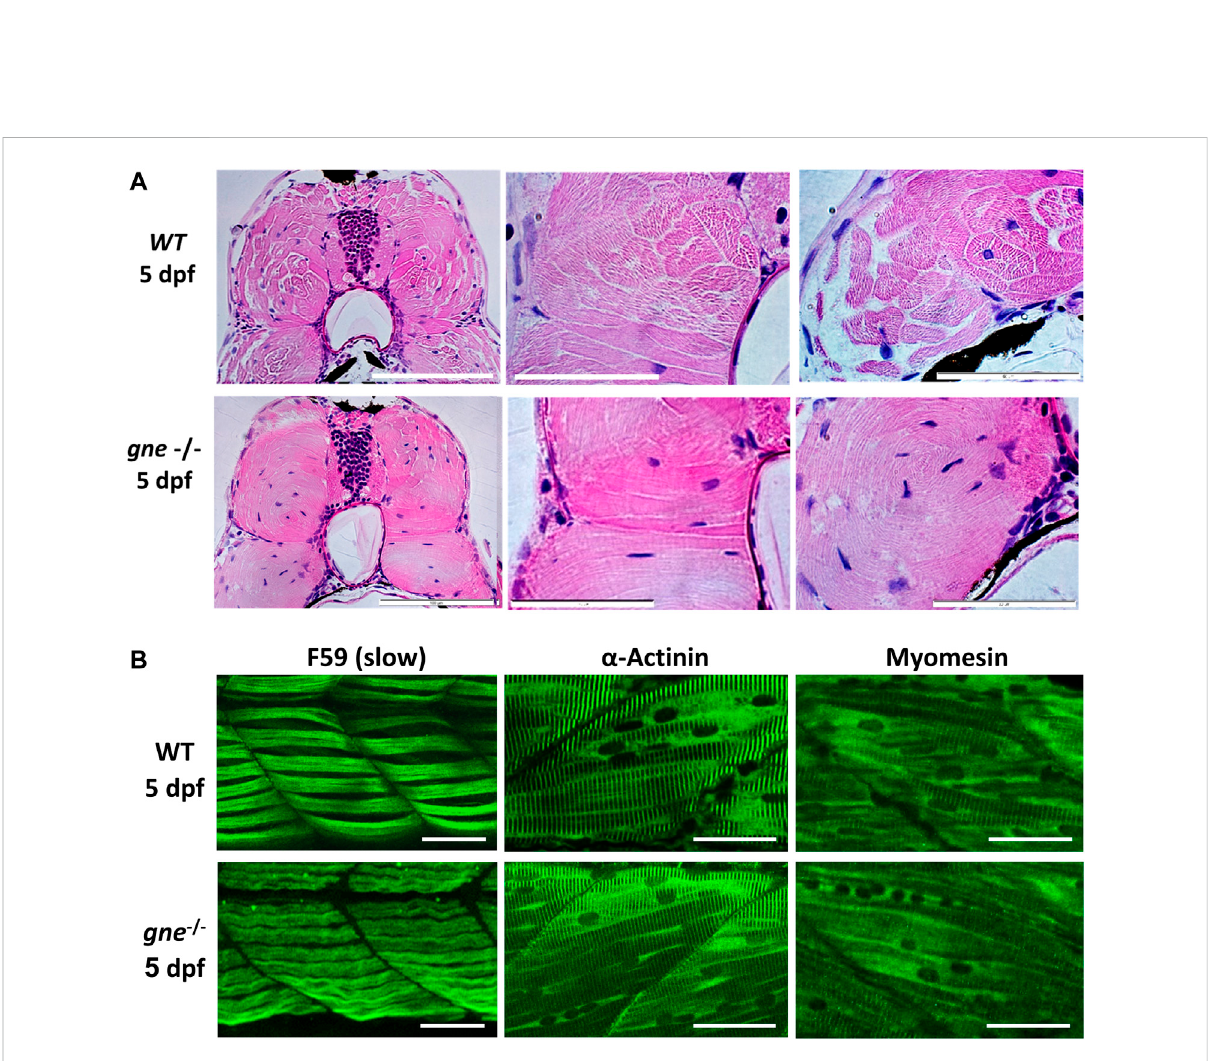
FIGURE 5 gne KOlarvae presentdisorganization ofmuscle fi bersat5dpf. (A) H&E stainingofmusclecross-sections of gne WT(top)and gne KO(bottom) larvaedisplayabnormallyorganizedmyo fi berswithunde fi ned fi berbundles.Scalebar=100 µm(left),50 µm(middleandright). (B) Confocalimaging of whole-mount immunostained larvae at 5 dpf by gne genotype. gne KO exhibits a slightly wavy pattern of the slow muscle fi bers (F59) and structurally normal fast fi bers (stained with Actinin and Myomesin) with proper localization. Scale bar = 50